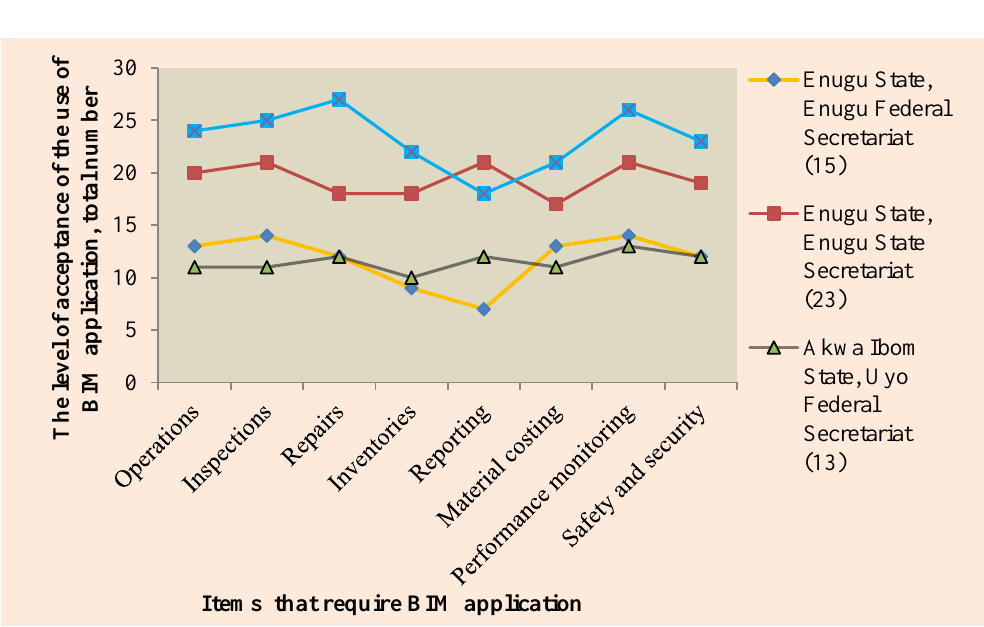
Fig. 8. Acceptance of the use of BIM for property management (developed by the